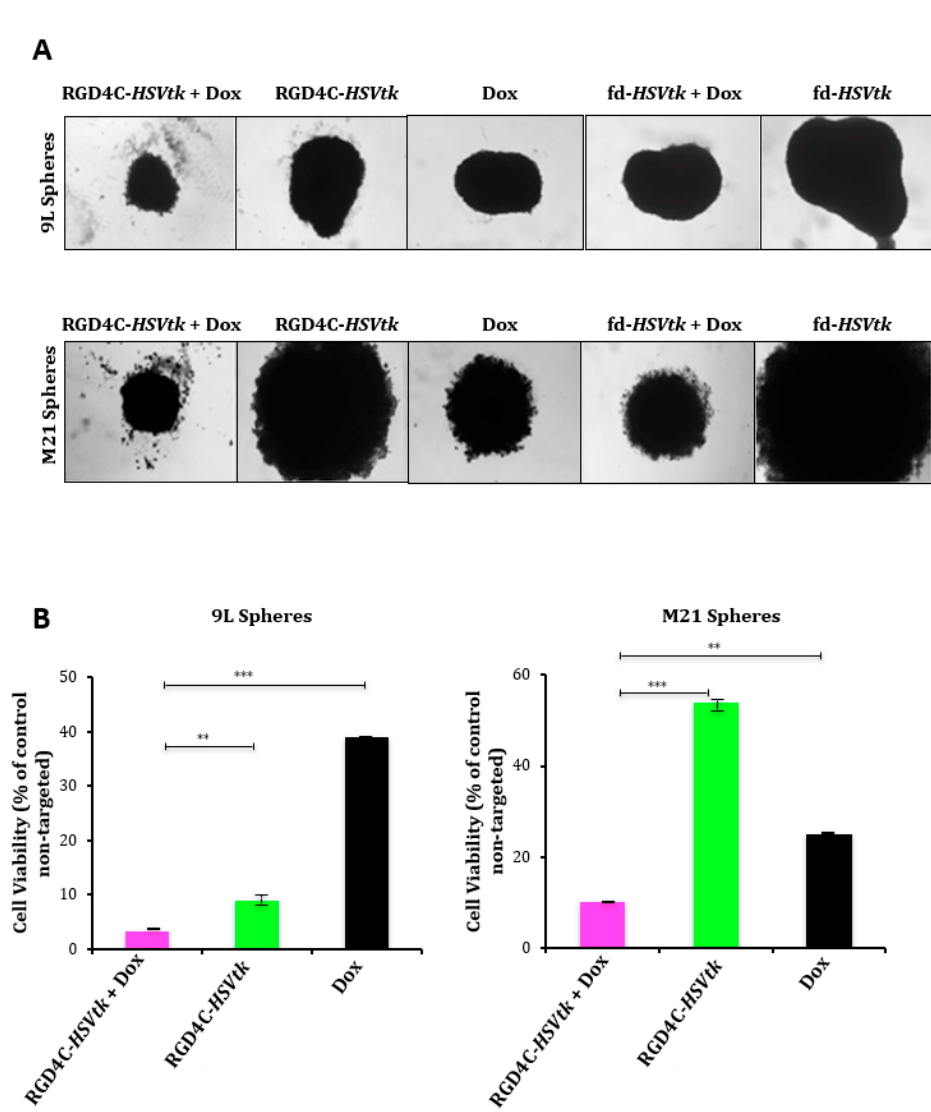
Figure 6. Antitumor e ffi cacy of the combination between Dox and RGD4C / AAVP- HSVtk plus GCV in tumor spheres. ( A ) Bright-field images showing the size of 9L and M21 spheres following transduction with RGD4C- HSVtk or fd- HSVtk , the nontargeted vector, in the presence or absence of doxorubicin (0.5 µ M for 9L and 0.6 µ M for M21 spheroids). GCV was added to the spheres at day 5 post-vector transduction and renewed every 2 days. Images were taken at days 5 or 7 post-GCV treatment for 9L and M21 spheres, respectively. Original magnification × 20. ( B ) Evaluation of cell viability in 9L and M21 spheres at days 5 or 7 post-GCV treatment, respectively. Cell viability was assessed by using the Cell Titer-Glo cell viability assay. The experiments were repeated twice in triplicate, and the results shown are representative of one experiment. ** p < 0.01 and *** p <